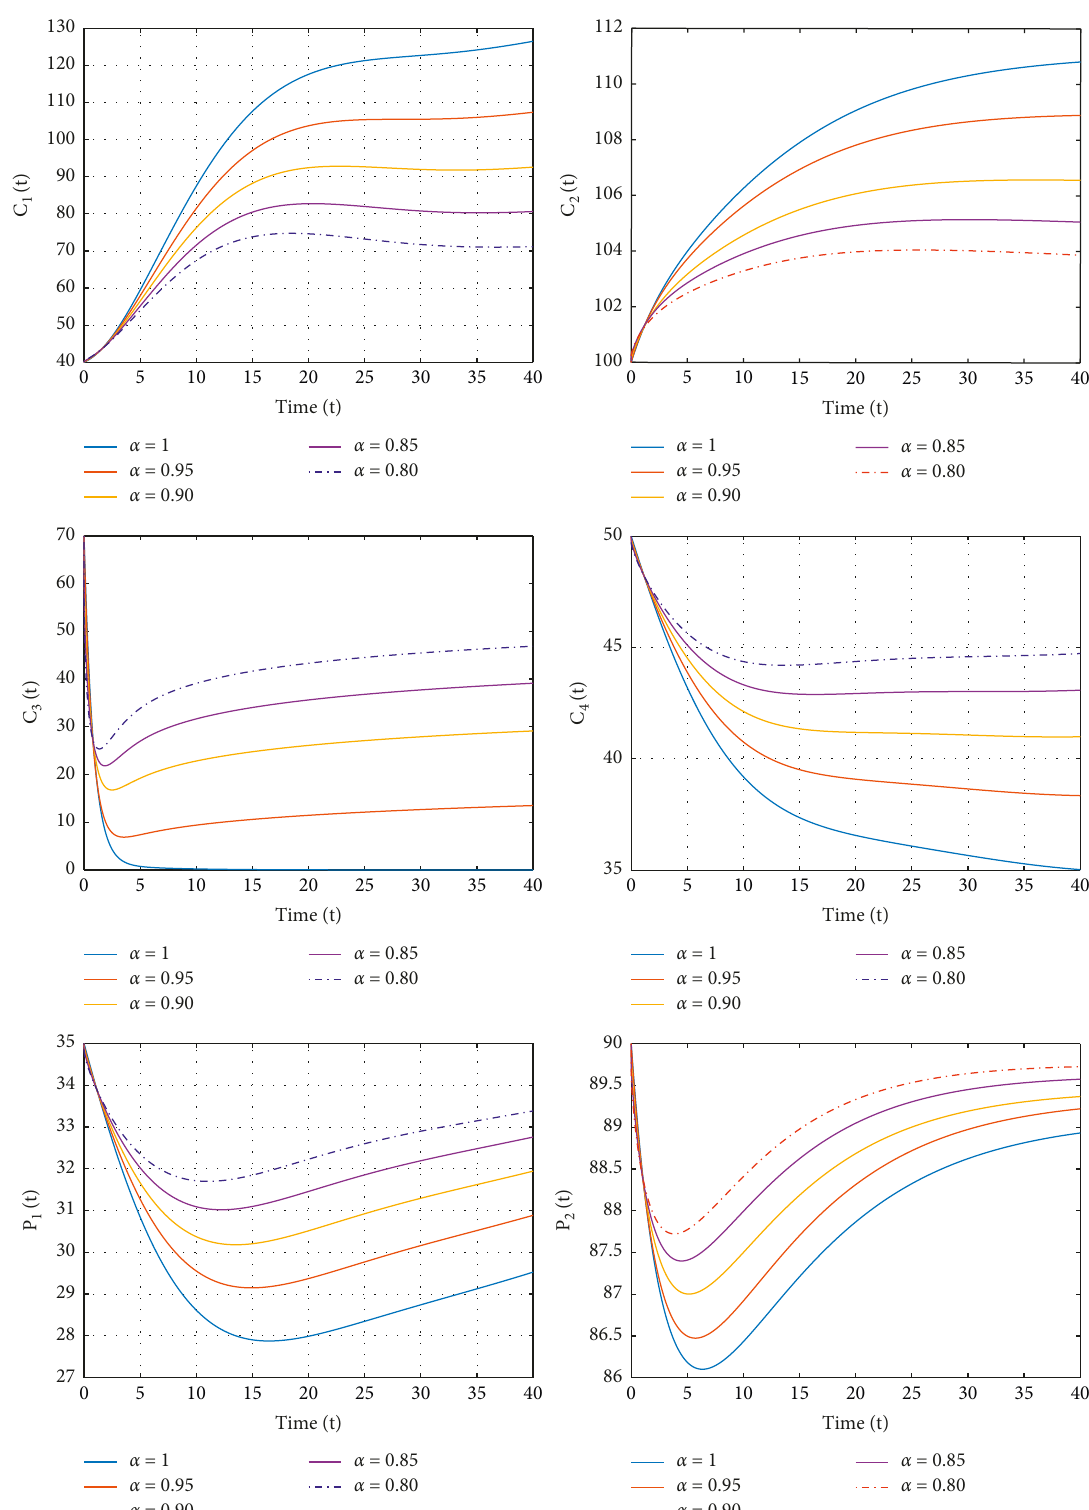
Figure 1: Fractional dynamics of reactants C